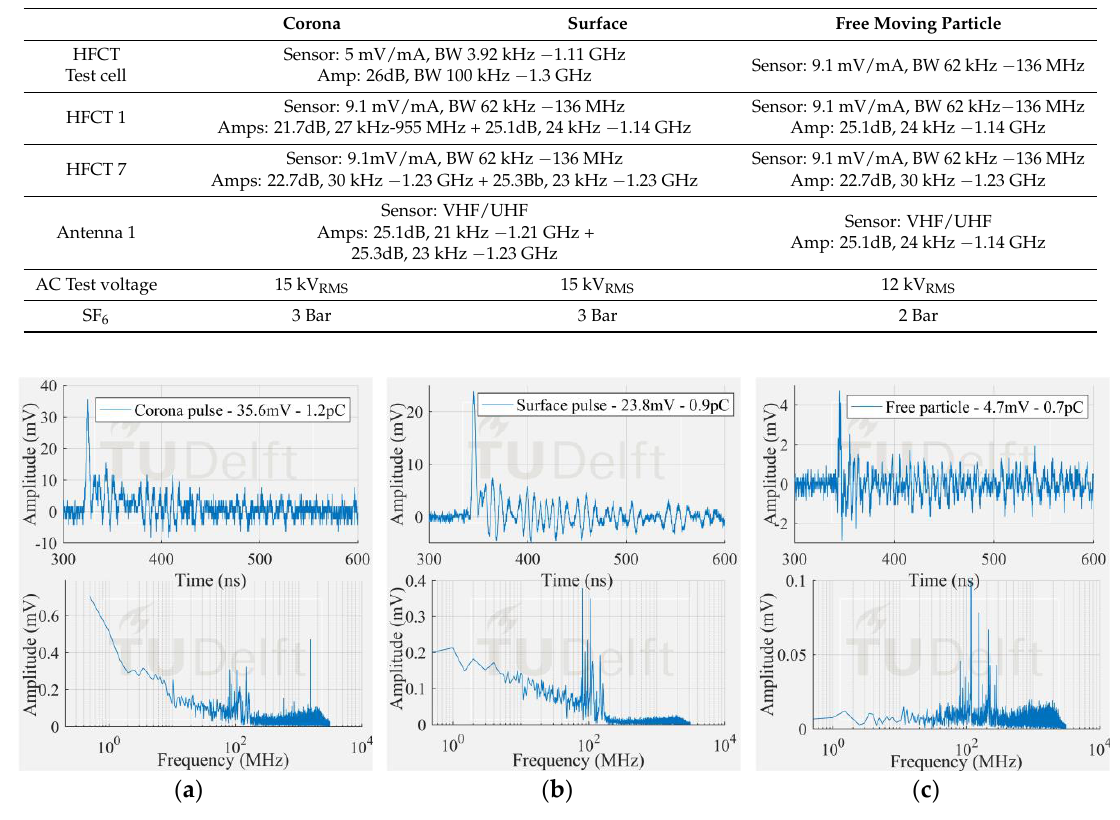
Figure 9. Smallest pulse at the test cell ( a ) corona; ( b ) surface; ( c ) free moving particle.